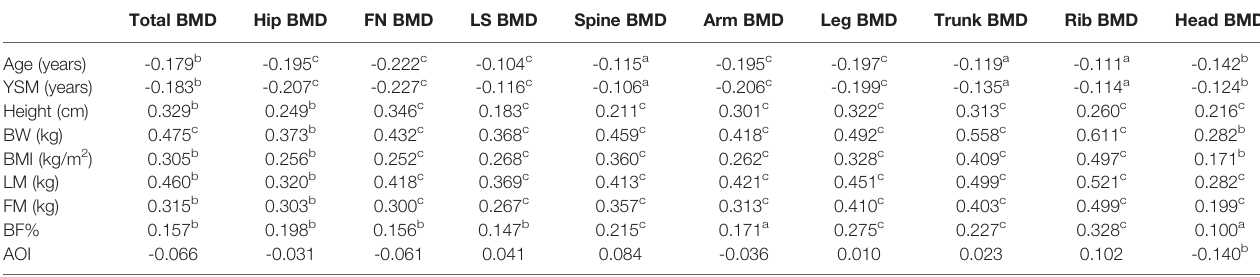
TABLE 2 | Correlations between subject characteristics, body composition and total body. and regional BMD measurements.